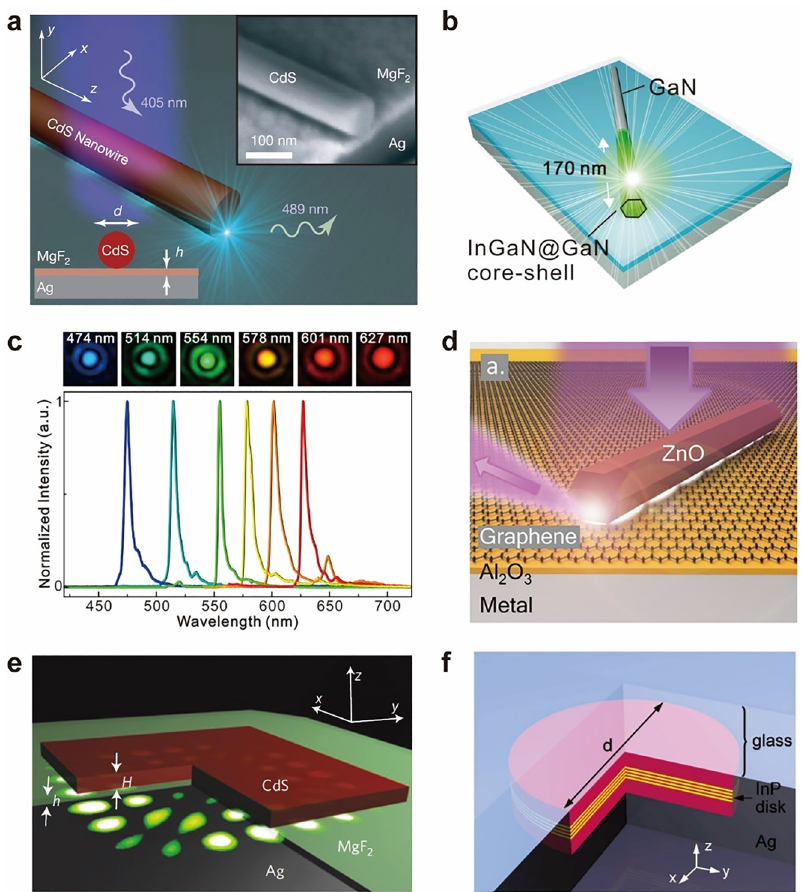
Figure 1: Examples of various plasmonic